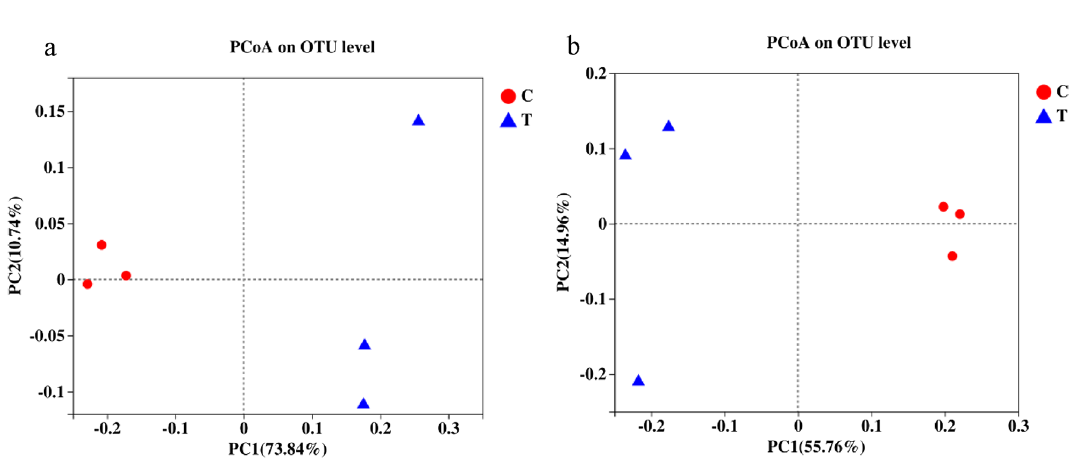
Figure 7. Principal coordinate analysis (PCoA) plots based on the Bray–Curtis dissimilarity matrix showing the changes in the structure of bacterial ( a ) and fungal ( b )